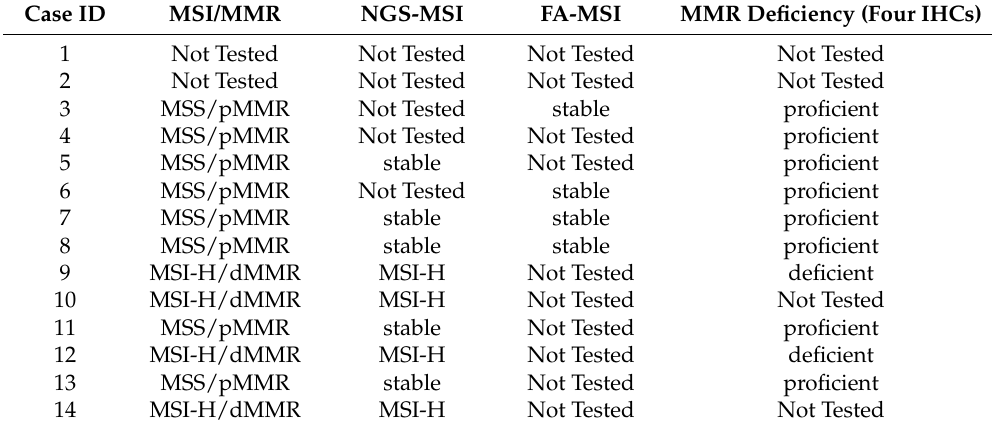
Table 2. Determination of MSI-H/dMMR status in the 14 KRAS A59T-mutated CRC tumors. MSI-H-